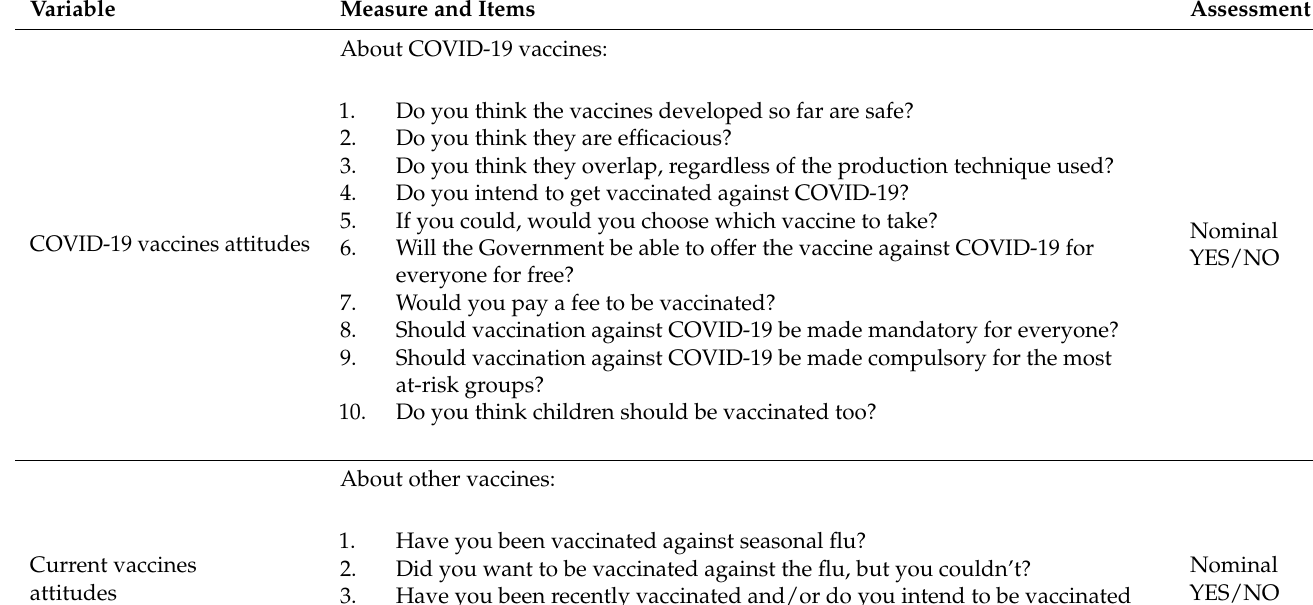
Table 2. January 2021 survey—questions used to assess attitudes about COVID-19 and flu vaccines.